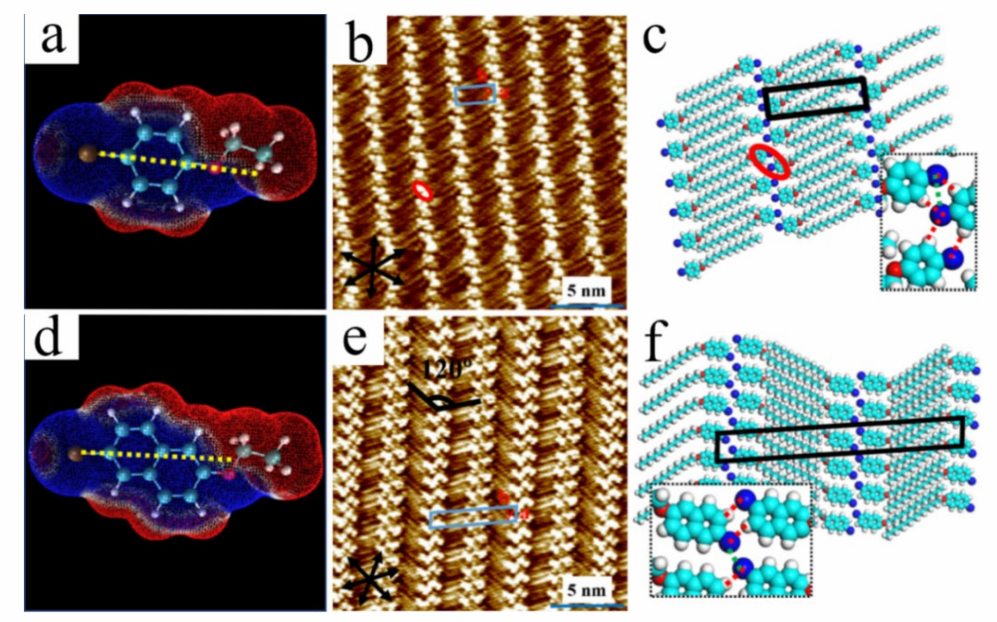
Figure 3. ( a , d ) Calculated electrostatic potential (ESP) maps of Br-BC16 and Br-NC16 under vacuum shown by red (positive) and blue (negative) regions. ( b , e ) High-resolution STM images of adlayers formed by Br-BC16 and Br-NC16 at the 1-octanoic acid / graphite interface. ( c , f ) Proposed molecular models for ( b , e ). Insets show the intermolecular interactions. The red lines show the H ··· Br bonds, and the green lines show the Br ··· Br contact. Reproduced from [71] with permission from the American Chemical